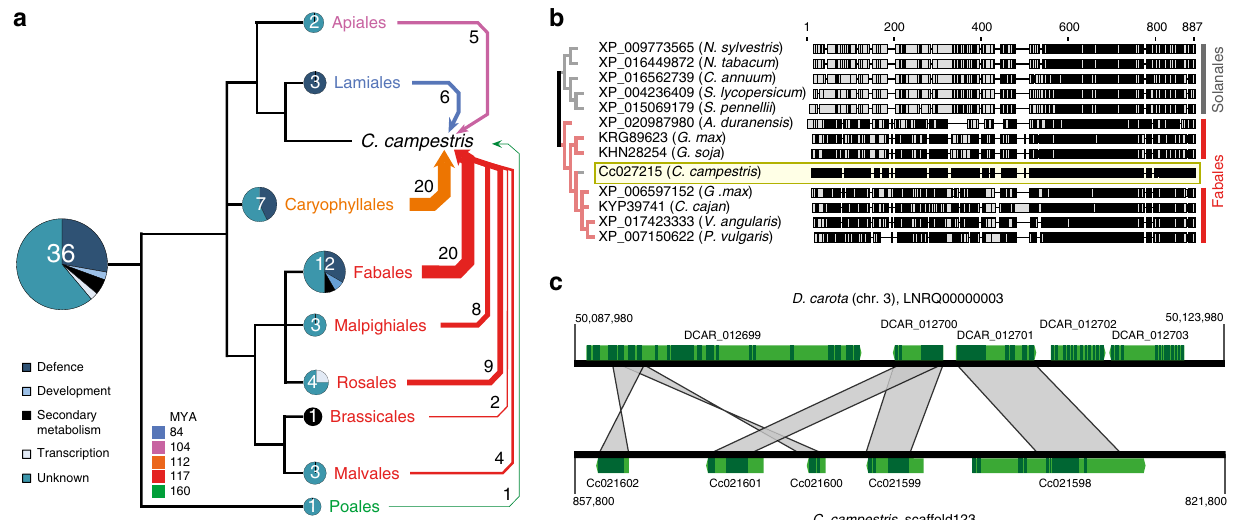
Fig. 5 Horizontal gene transfer (HGT) in C. campestris . a Depiction of the phylogenetic origin of 36 HGT events and their functional category assignment. Phylogenetic orders from which HGT originated are color-coded according to their evolutionary distance to Cuscuta using the median values in million years (MYA) for the split as predicted by Timetree (http://timetree.org) and supported by a species tree calculated using Astral-II (Supplementary Fig. 5). White numbers refer to the number of genes per donor order, black numbers to the right indicate the number of genes in the recipient, C. campestris . Cake diagrams represent functional assignment of donor genes in MapMan bins 17 . b Phylogenetic placement of HGT candidate protein Cc027215, a G-type lectin S-receptor-like serine/threonine-protein kinase, Callus Expression of RBCS 101 (CES101). The amino acid sequence of Cc027215 (highlighted in yellow) is nested deeply within a cluster of orthologous proteins from the hypothetical donor order Fabales (in red), while all orthologs from Solanales species (in gray), that are much more closely related to C. campestris , are located on the second branch. The schematic sequence comparison shows identities relative to Cc027215 in black boxes, discrepancies in gray boxes and gaps in the alignment as black lines. Bootstrap values after 1000 replicates were 86% or higher for all nodes. c Nucleotide sequence comparison of a 36 kb region of chromosome 3 from Daucus carota (top) and a region of C. campestris scaffold123. Coding sequences are shown in dark green and introns as well as up- and down-stream untranslated fl anking regions are shown in light green. Areas with very high similarity, indicating conserved remnants of a previous horizontal DNA transfer between both species are indicated by gray fi elds. Within the depicted area, a gene duplication ( Cc021601 and Cc021599 both mapping with all three exons and two introns to DCAR_012700 ), a larger sequence insertion between Cc021599 and Cc021598 , as well as sequence inversions can be